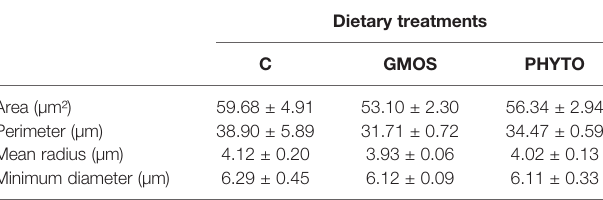
TABLE 4 | Gill goblet cells morphometry of juvenile European sea bass ( Dicentrarchus labrax ) at the end of the feeding trial (63 days). Dietary